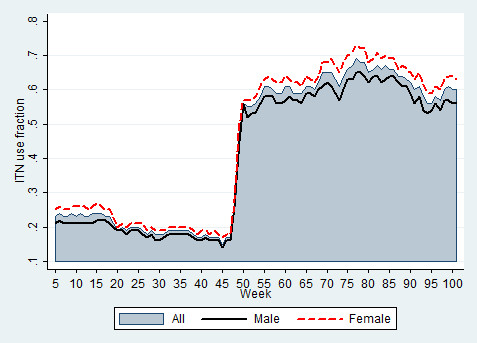
Insecticide-treated bed net use fraction by gender.